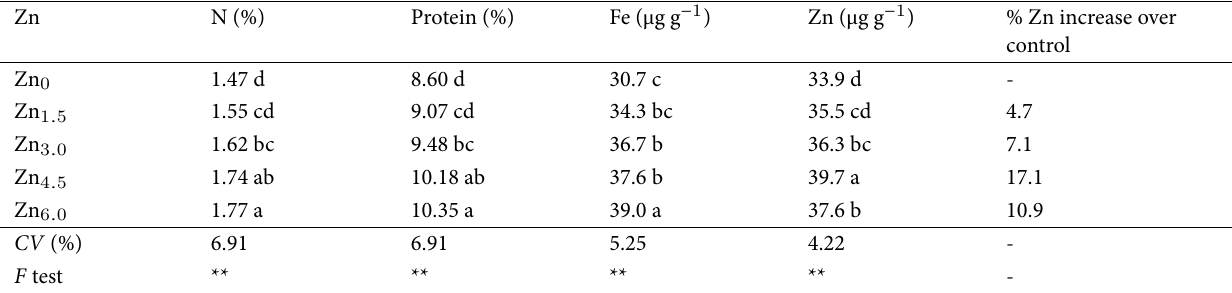
Table 7 Nitrogen, protein, Zn, and Fe concentrations of wheat grains influenced by zinc rates.